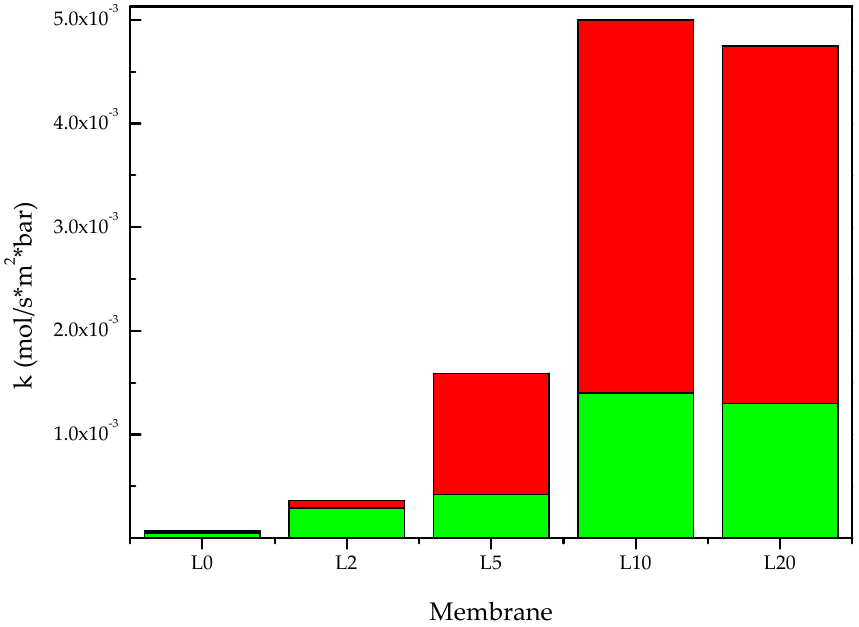
Figure 9. Mass transfer coe ffi cient of L0–L20 membranes relative to: N 2 ( green bar ); CO 2 ( red bar ).